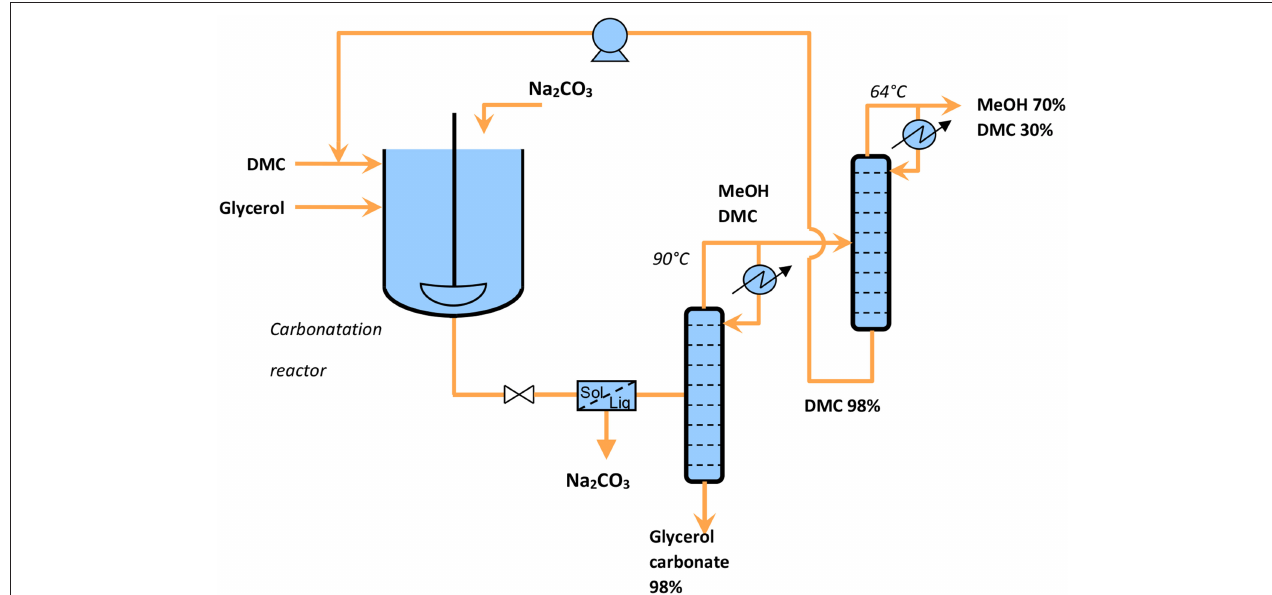
FIGURE 8 | Continuous process proposed for glycerol carbonate